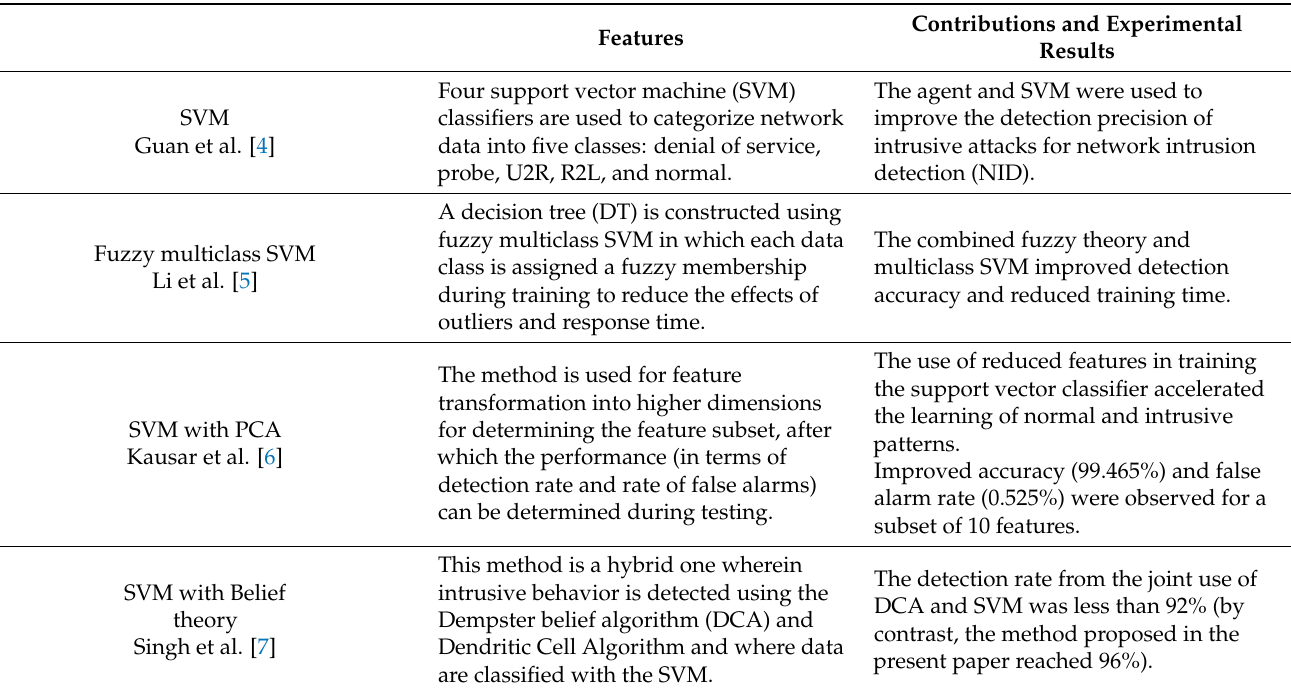
Table 1. Machine learning approaches for network threat